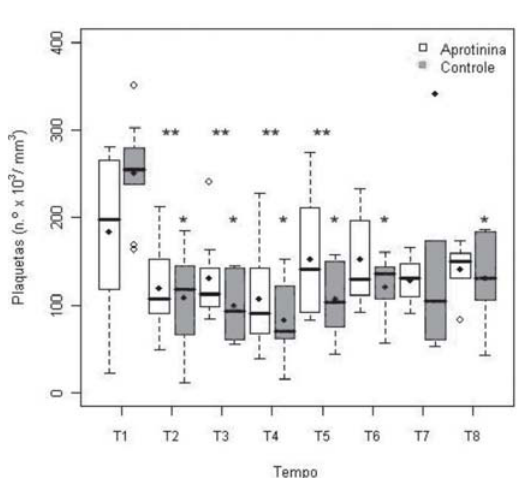
Fig. 2 - Taxas de hematócrito (%) nos grupos Aprotinina e Controle, nos tempos T1 a T8. As diferenças estatisticamente significativas estão assinaladas